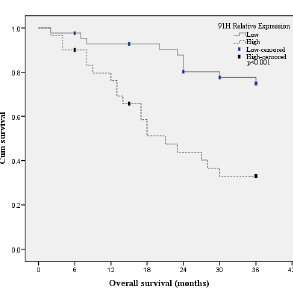
Figure 4. Kaplan-Meier overall survival curves based on 91H relative